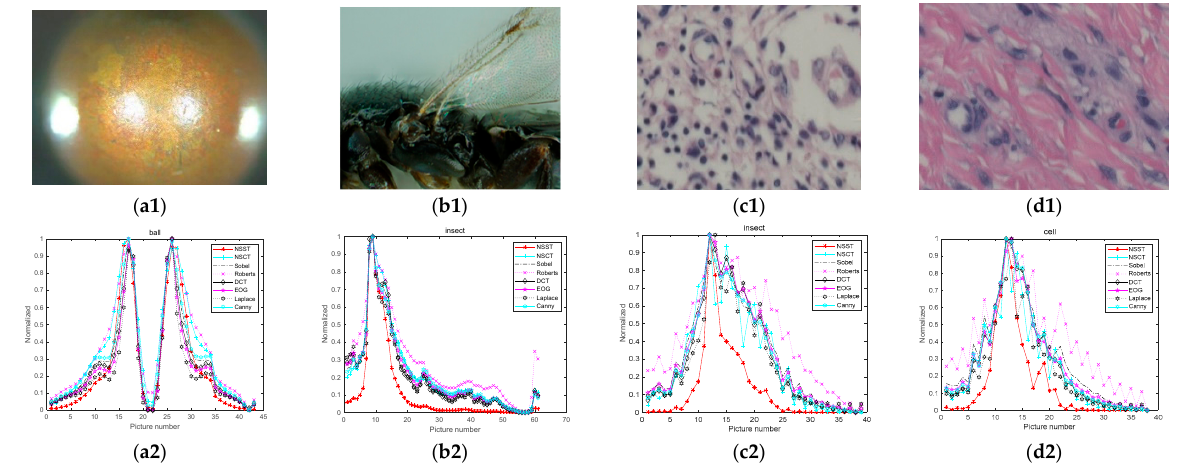
Figure 6. Sharpness evaluation curve of each algorithm for the public data: ( a1 ) ball image; ( b1 ) insect image; ( c1 , d1 ) biomedical cell images; ( a2 ) ball sharpness evaluation curve; ( b2 ) insect sharpness evaluation curve; ( c2 , d2 ) biomedical cell image sharpness evaluation curve. Both advantages and disadvantages of an algorithm can be analyzed based on